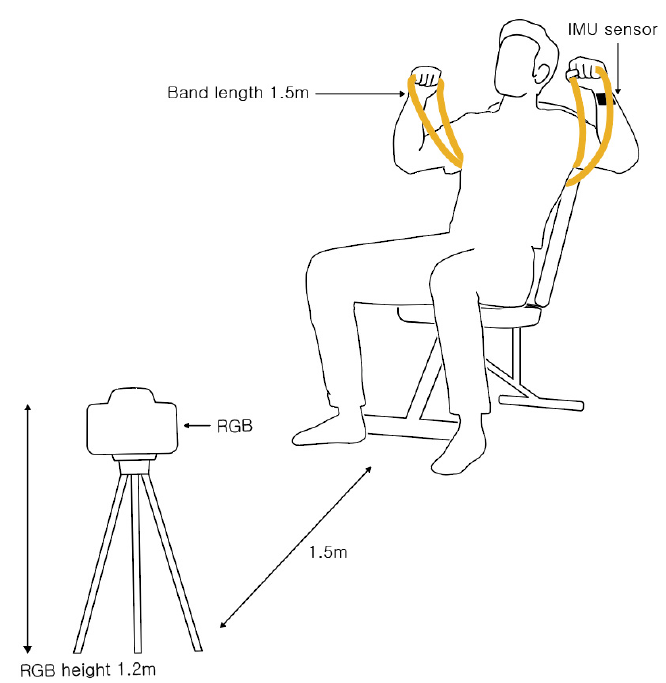
Figure 1. Schematic of the experimental environment. An RGB camera is located 1.5 m in front of the subject at a height of 1.2 m. An inertial measurement unit (IMU) sensor is attached to the subject’s left wrist. The resistance bands are folded in half and used as double layers.